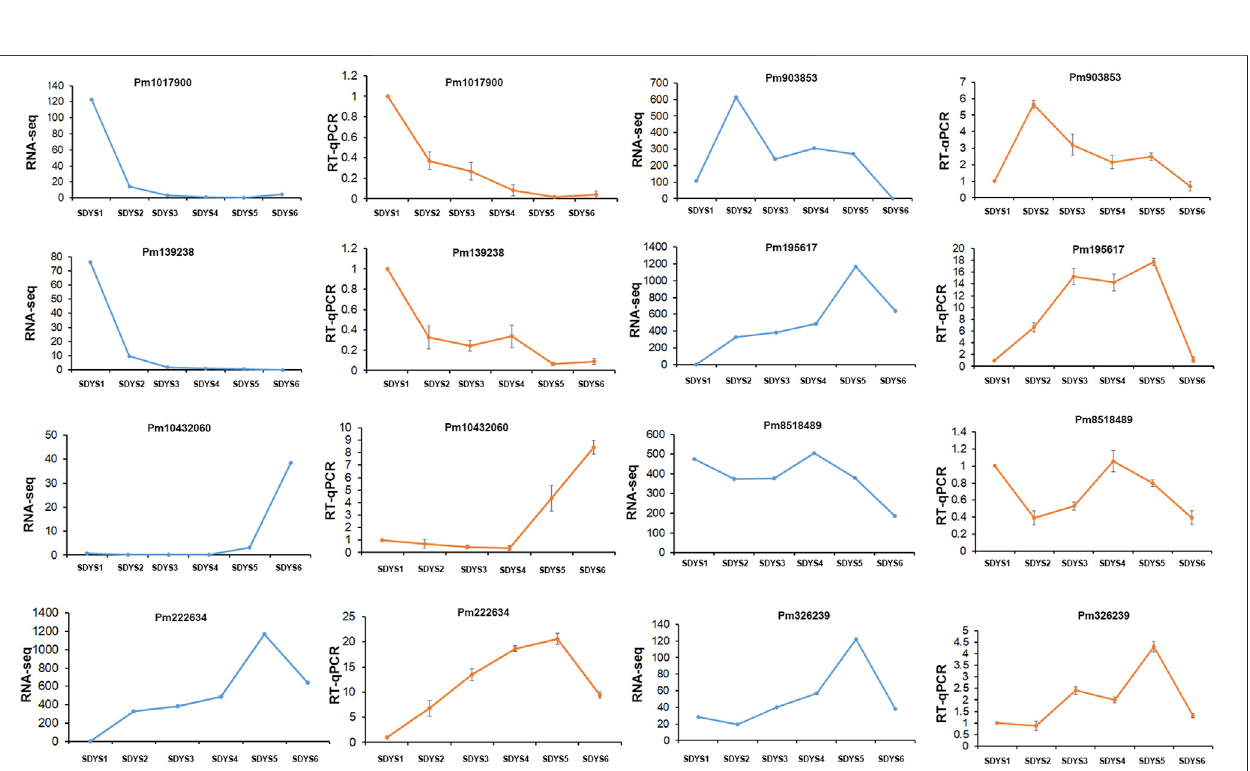
FIGURE 3 | Validation of RNA-seq results via RT-qPCR Fold changes for selected transcripts obtained by RNA-seq and RT-qPCR are shown for each developmental time point. Transcript levels are means ± SD of three biological replicates.